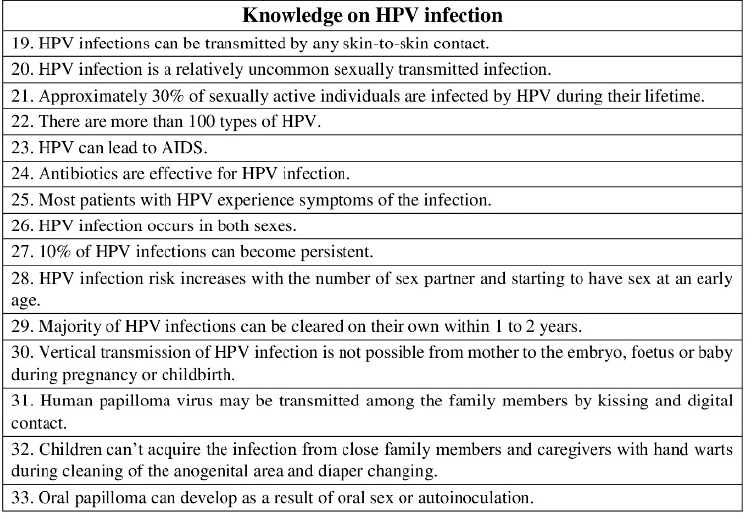
Figure 2. Questionnaire assessing pediatric dentists’ knowledge on HPV infection. Statements used required one of the following responses: “true”/“false”.